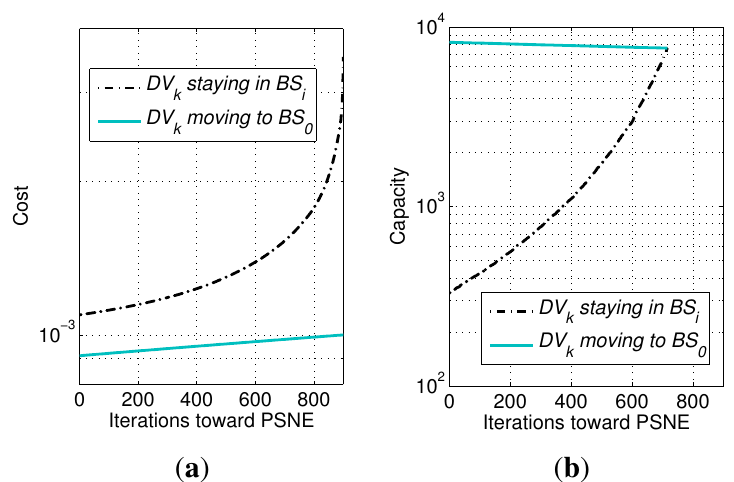
Figure 4. Monotonicity of payoff functions in Theorems 2 and 3. Obtained by setting B = 2 / 3 B = 300 m, w = 3 × 10 6 and other parameters commonly , R i 0 i